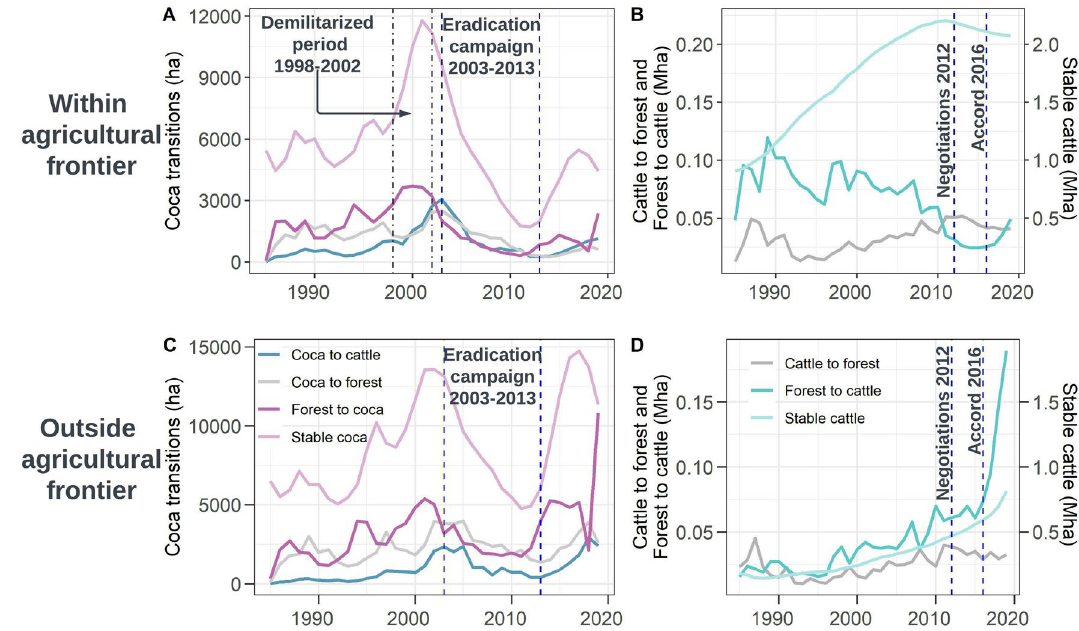
Figure 3. Mapped areas for the conversion patterns forest-coca-cattle . First row represents conversion patterns within the legal agricultural frontier defined in 2018, second row shows the patterns outside the frontier, in which agriculture is considered